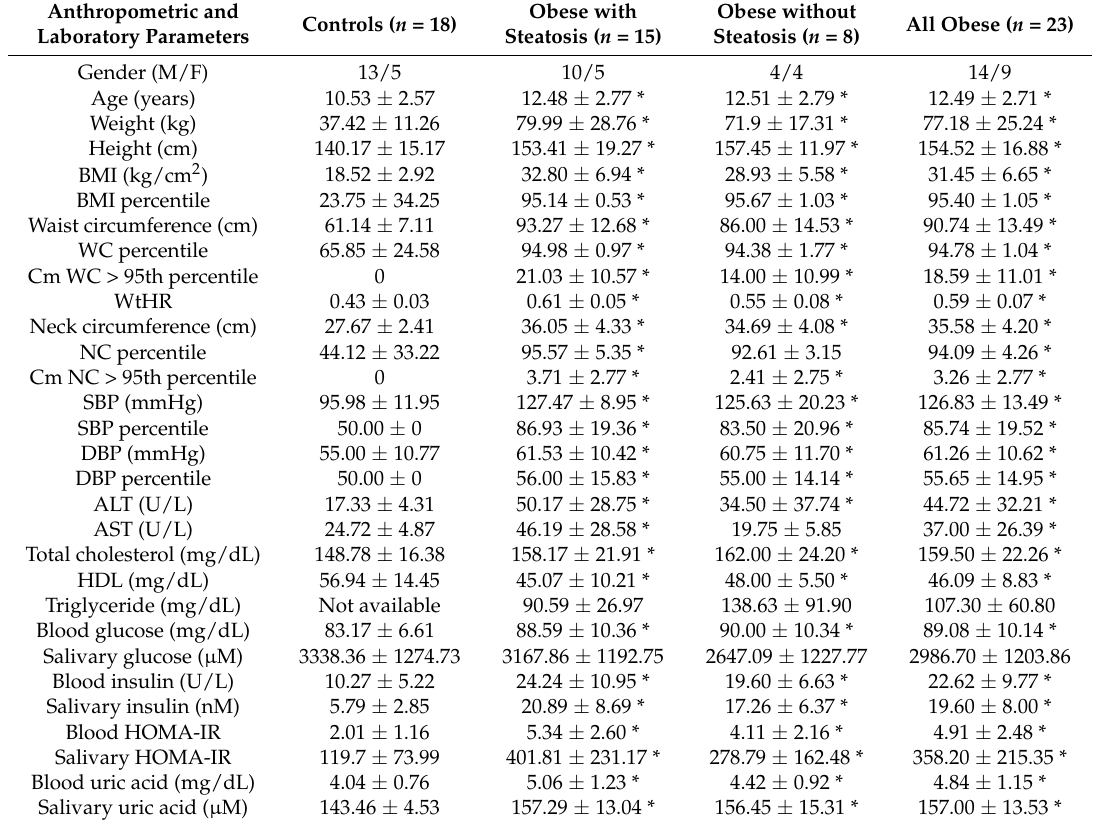
Table 1. Characteristics of the study